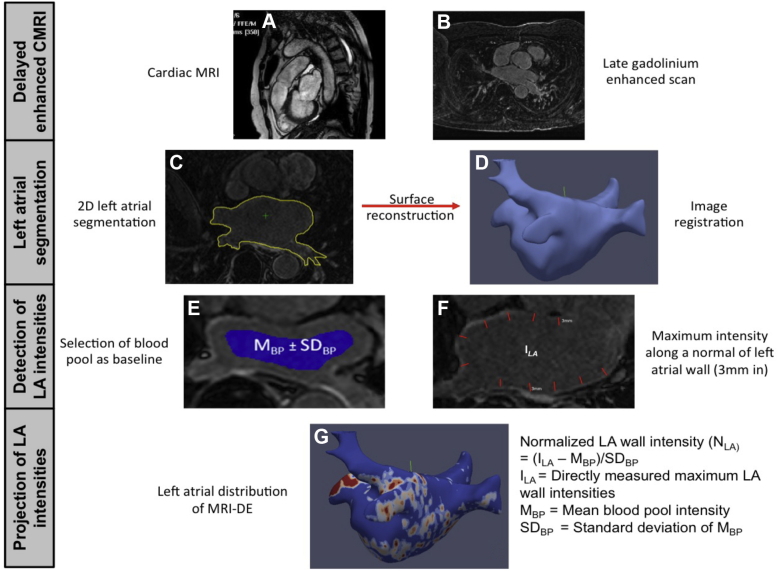
Schematic representation of the generation of left atrial (LA) delayed-enhancement magnetic resonance imaging (MRI-DE) models. 2D = 2 dimensional; MRI = magnetic resonance imaging.